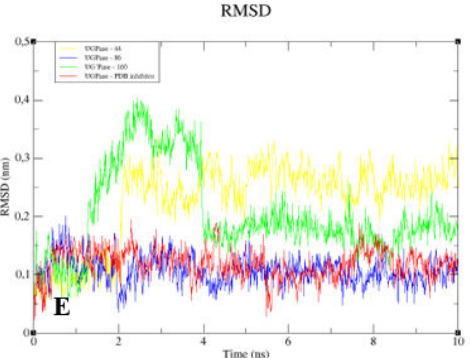
Figure 10. The RMSD values of the C α atoms of the lignans and the PDB ligand. ( A ) GPDH. ( B ) DHODH. ( C ) PTR1. ( D ) TR. ( E ) UGPase.